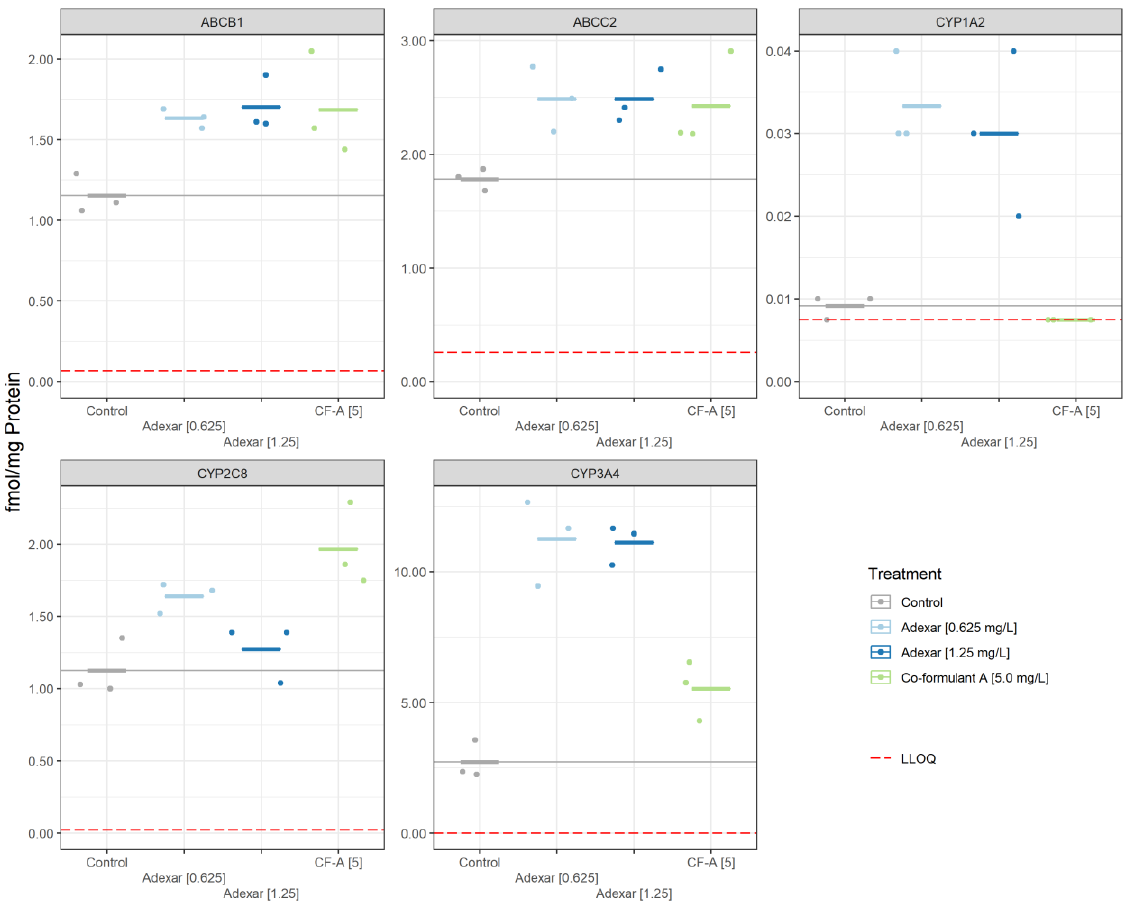
Figure 5: Treatment-related changes in protein concentration in HepaRG cells. Results were generated based on an MS-based immunoassay. Cytochrome P450 enzymes and the respective ABC transporter were quantified after 24 h treatment with the substances Adexar ® at 0.625 mg/L and 1.25 mg/L (ex- pressed as the active substances´ concentration within the product); and co-formulant A of Adexar® (5.0